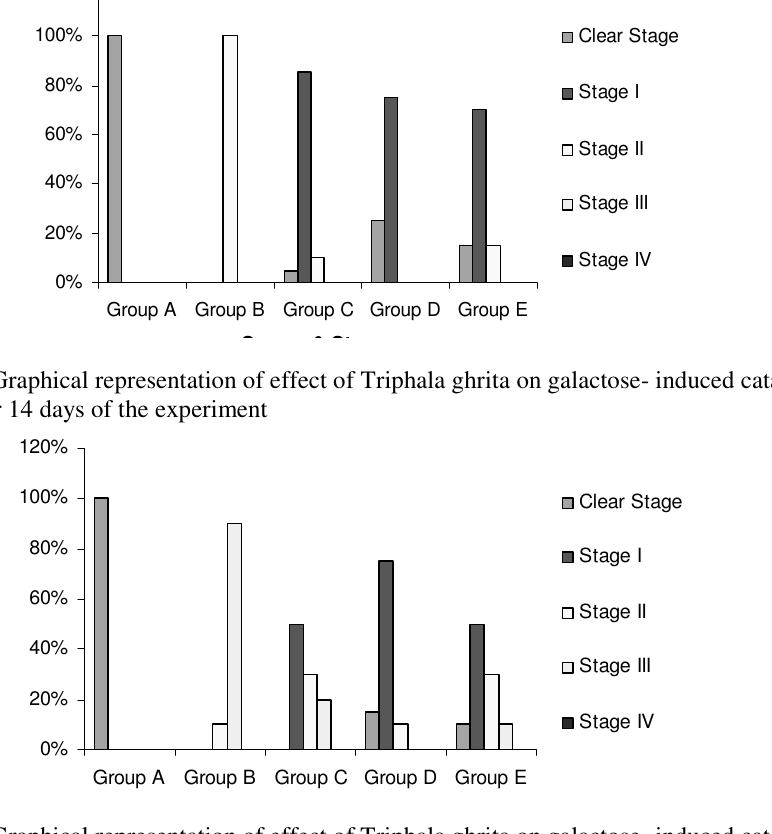
Figure 3. Graphical representation of effect of Triphala ghrita on galactose- induced cataract in rats after 21 days of the experiment